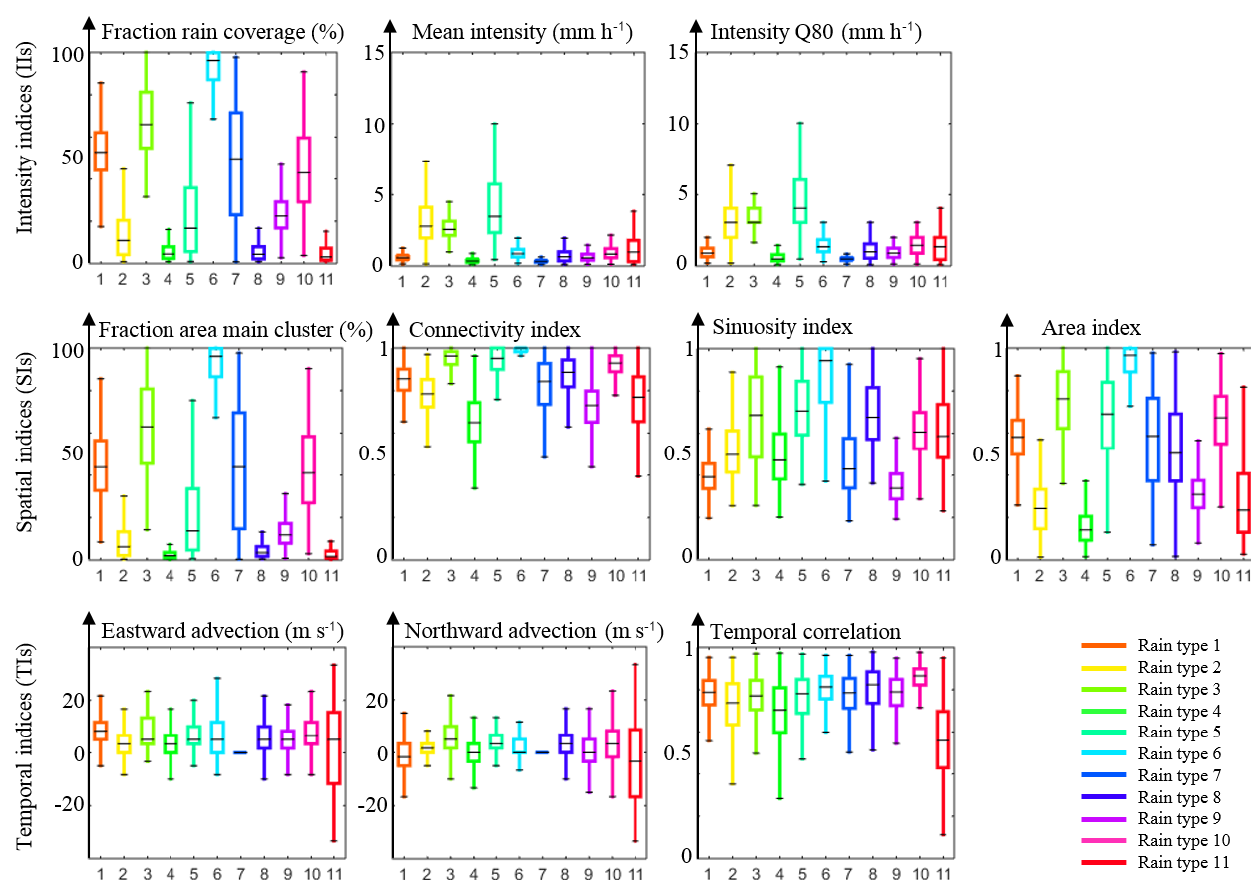
Figure 9. Marginal distributions of the indices used for rain type classification. Each graph represents a different index. Colours denote rain